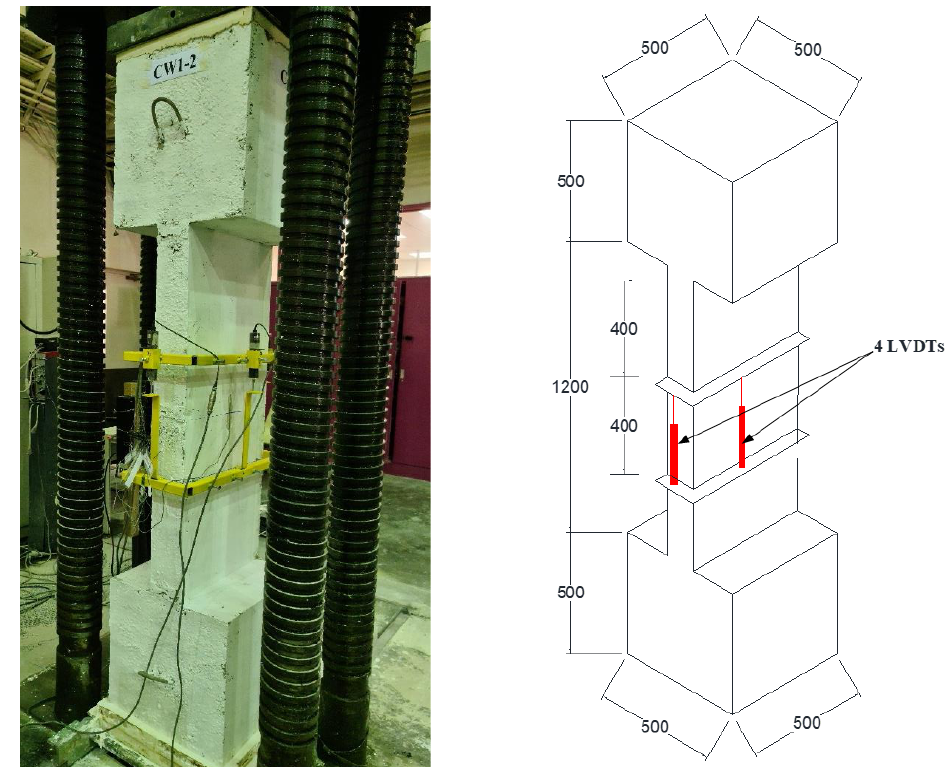
Figure 7. Test setup with instrumented specimen ready for testing.